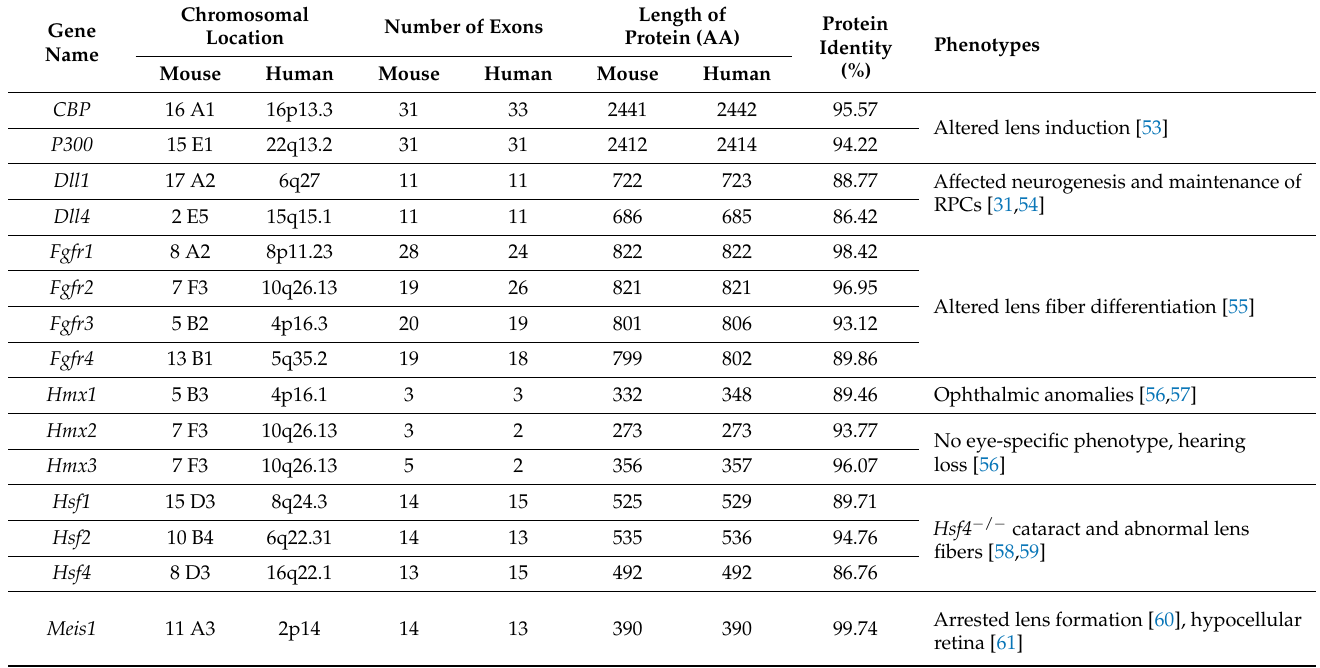
Table 1. Overview of paralogous genes involved in eye